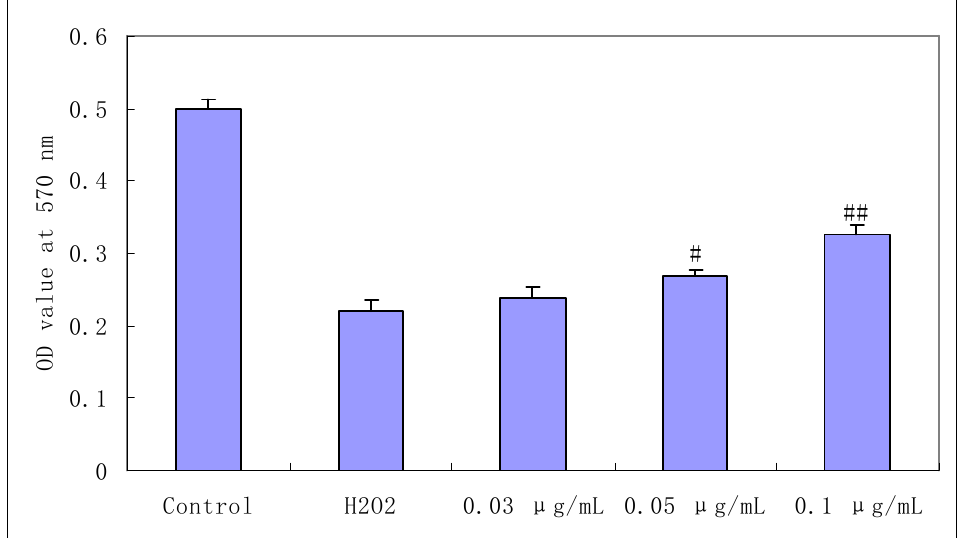
Figure 2. Protective effect of salidroside on H with salidroside followed by H MTT assay.